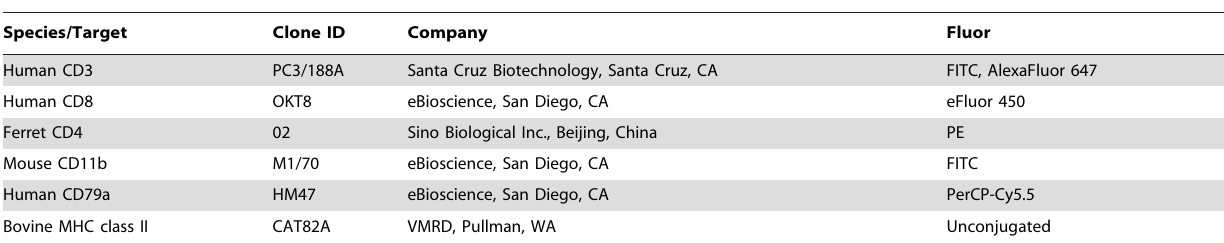
Table 1. Antibodies used in this